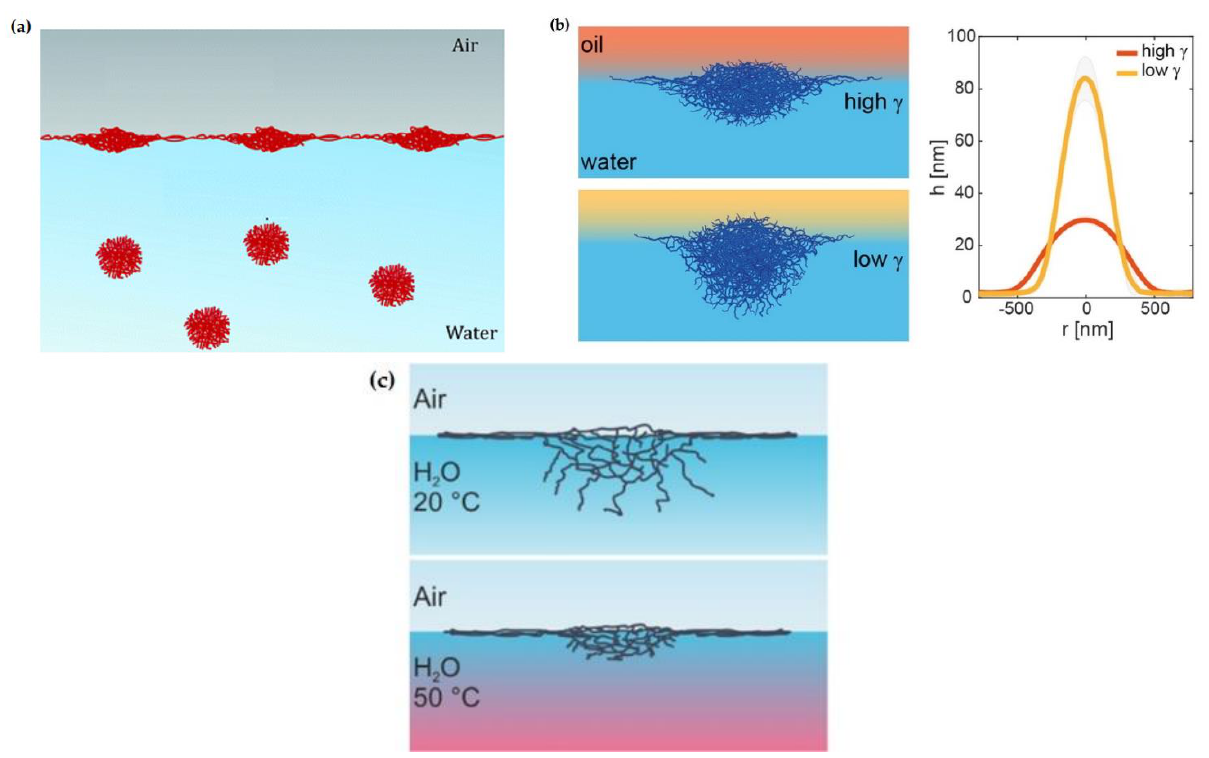
Figure 1. ( a ) Sketch of the microgel deformation upon adsorption to a fluid interface. Adapted from Deshmukh et al. [28] with permission from the Royal Chemical Society, Copyright (2014). ( b ) Conformation and dimension of microgel particles (characterized by the microgel radius at the contact length, r , and height, h ) at water/oil interfaces with different interfacial tensions ( γ ). Reprinted from Vialetto et al. [41] under the Creative Common Attribution License 4.0, 2022. ( c ) Sketch of the conformation of the PNIPAM microgel at a water/vapor interface at 25 °C and 50 °C. Reprinted from Harrer et al. [42] with permission from the American Chemical Society, Copyright (2019).